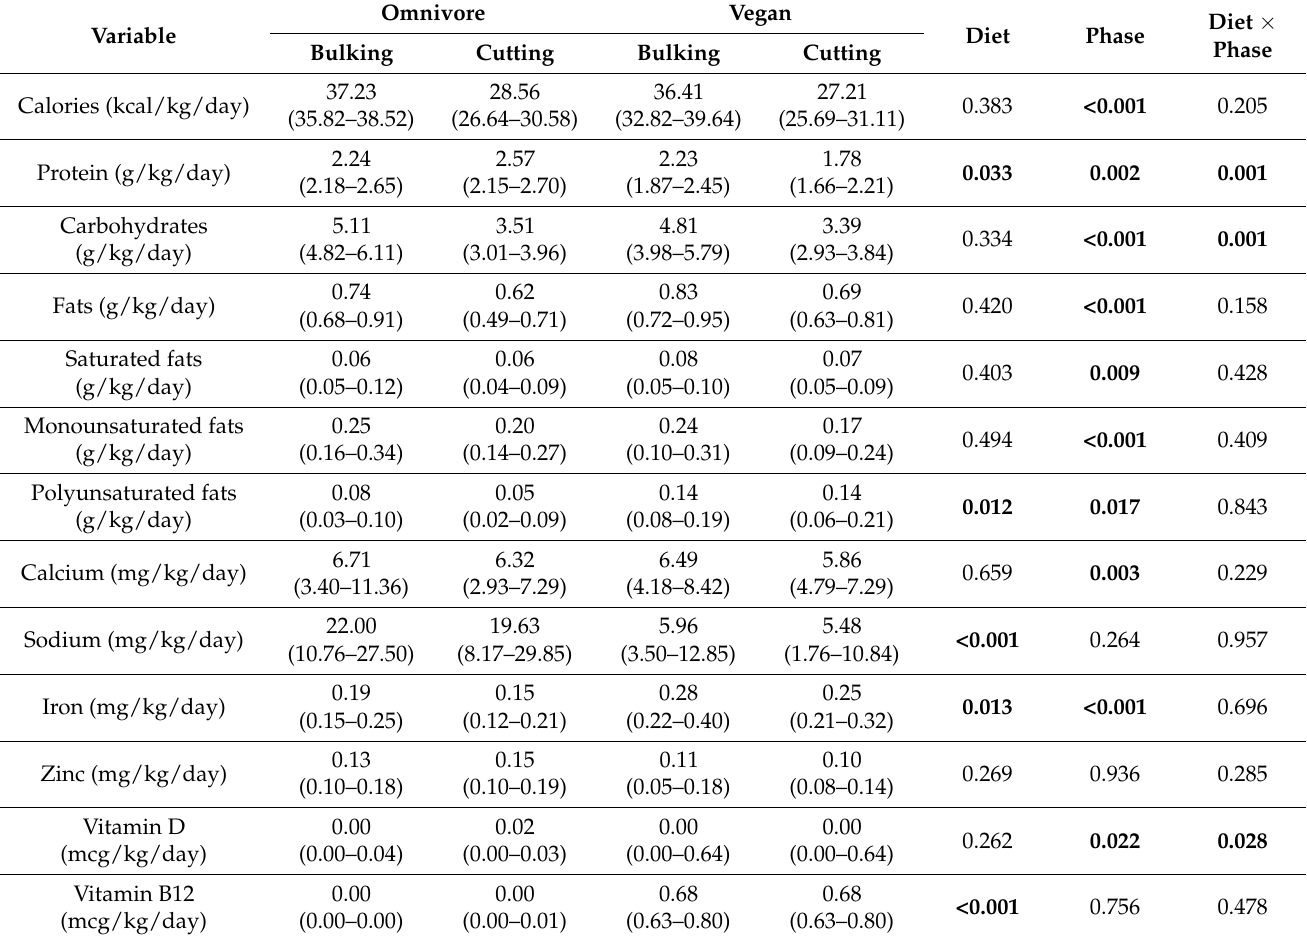
Table 1. Macronutrient and micronutrient differences between omnivore and vegan bodybuilders diets. Data are reported as median (first and third quartile). p -values are reported for diet, phase, and interaction diet × phase effects (values in bold are statistically significant p <